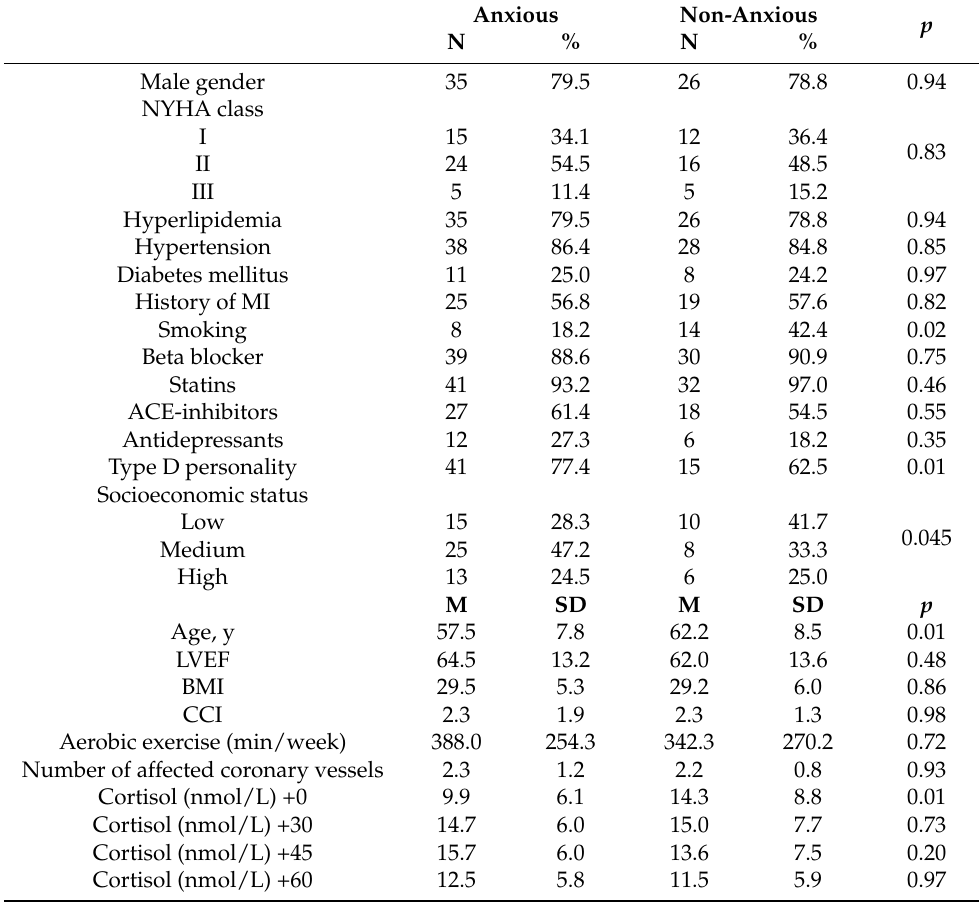
Table 2. Baseline characteristics compared between anxious vs.